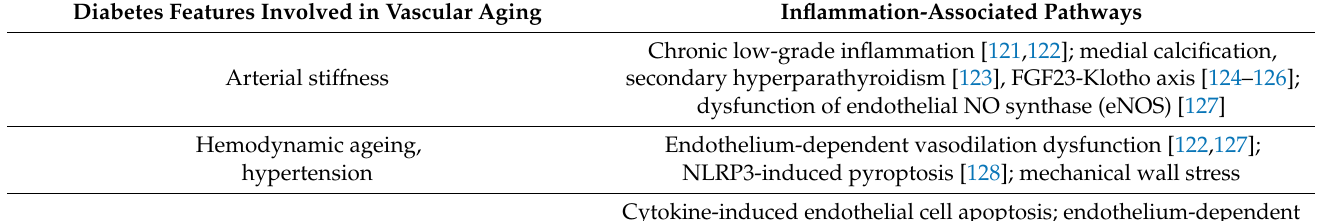
Table 2. Mechanistic links between diabetes and vascular